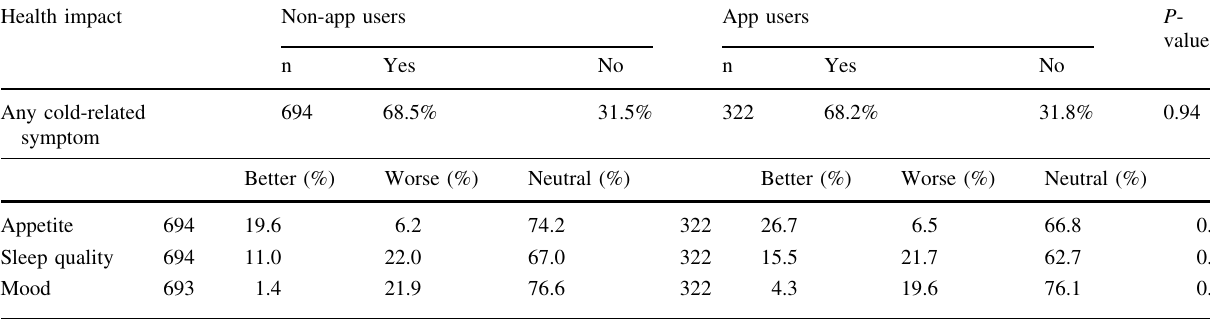
Table 4 Self-reported health impacts of cold weather by app users and